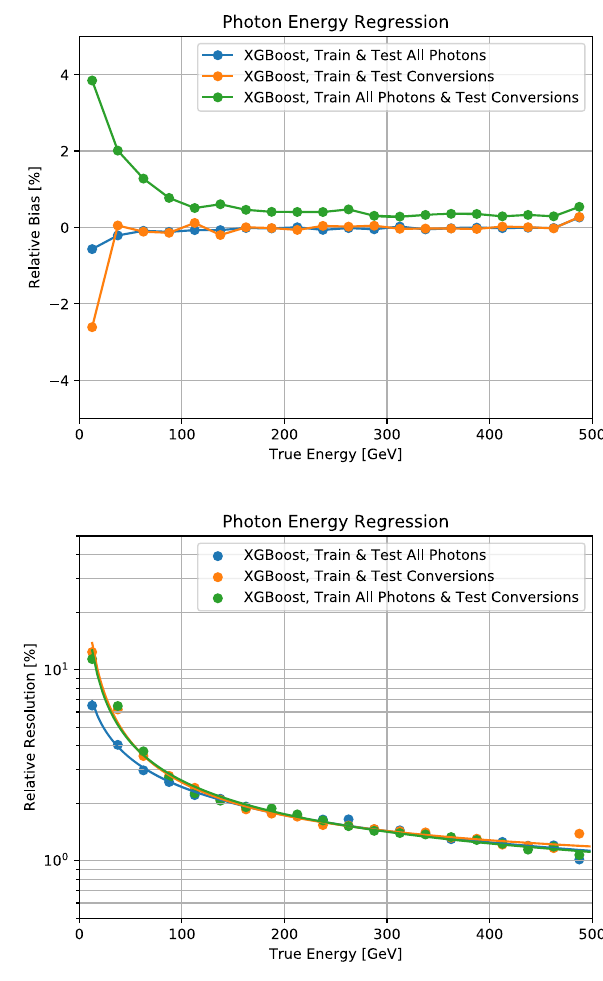
Fig. 38 Bias (top) and resolution (bottom) as a function of true energy, for photons using XGBoost regression. We look at the photon sample when split up by conversions